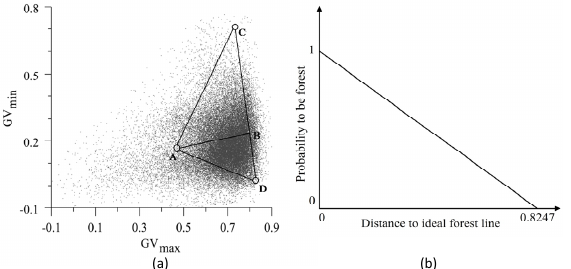
Figure 3. The scatter plots of fraction of green vegetation (GV) in summer and winter ( a ) and the forest utility function ( b ). Points C and D represent ideal evergreen and deciduous forests, respectively; line CD represents the ideal forest line. AC and AD represent relative probabilities for a pixel to contain evergreen or deciduous forest. A pixel is assumed to be evergreen forest with a probability of AD/(AC + AD), and deciduous with a probability of AC/(AC + AD).